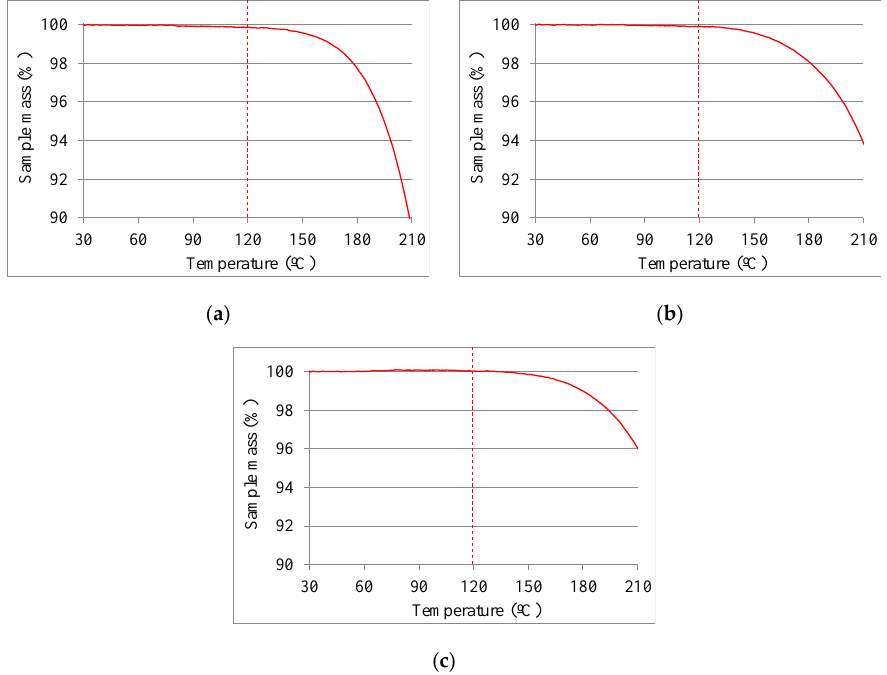
Figure 7. TGA analysis of the cycled PCM. (a) RT64HC; (b) PureTemp 63; (c) THP5860.